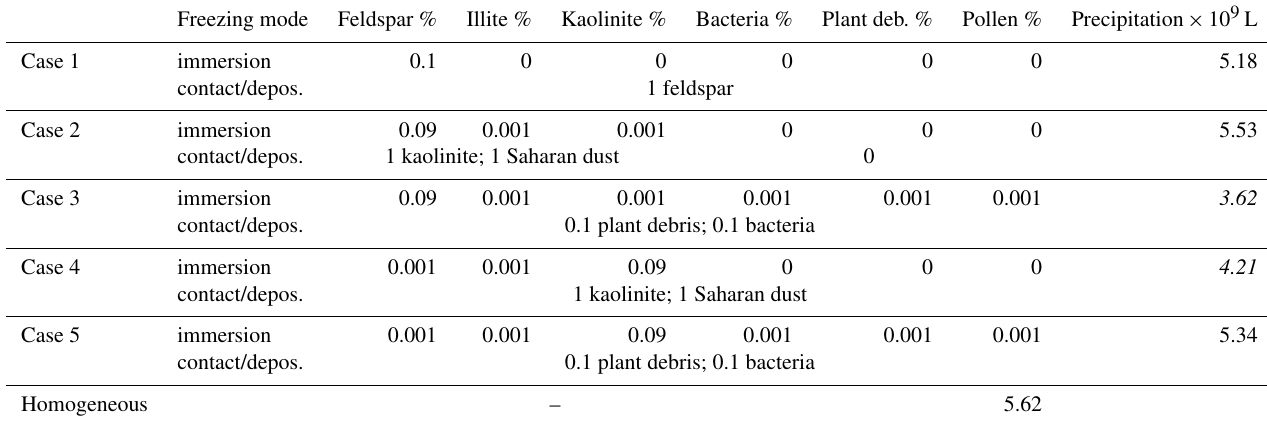
Figure 10. (a) Temporal development of precipitation during 180min of modeling time for coupled homogeneous and internally mixed immersion freezing. (b) Local distribution of precipitation through the cloud after 180min. Black line: reference case with homogeneous freezing. Colored lines mark the different cases as listed in Table 4. Table 6. Total precipitation after 180min of modeling time for mixed cases with coupled homogeneous, immersion, contact, and deposition freezing. Marked in italics: cases with more than 20% reduction of